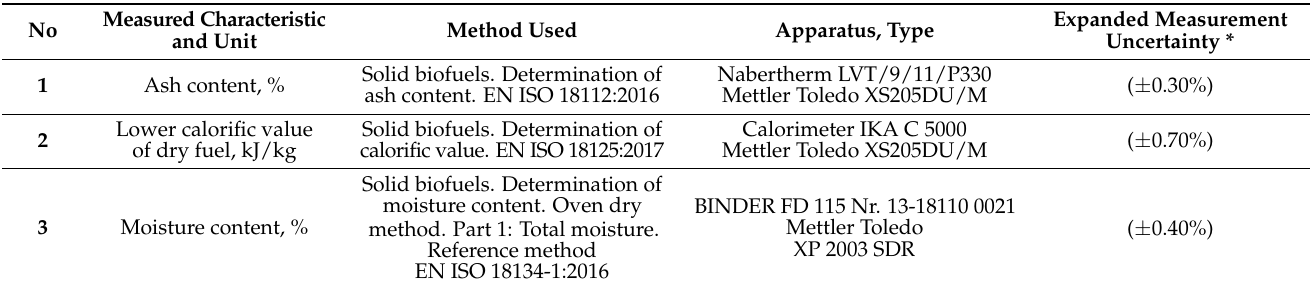
Table 2. Test apparatus and